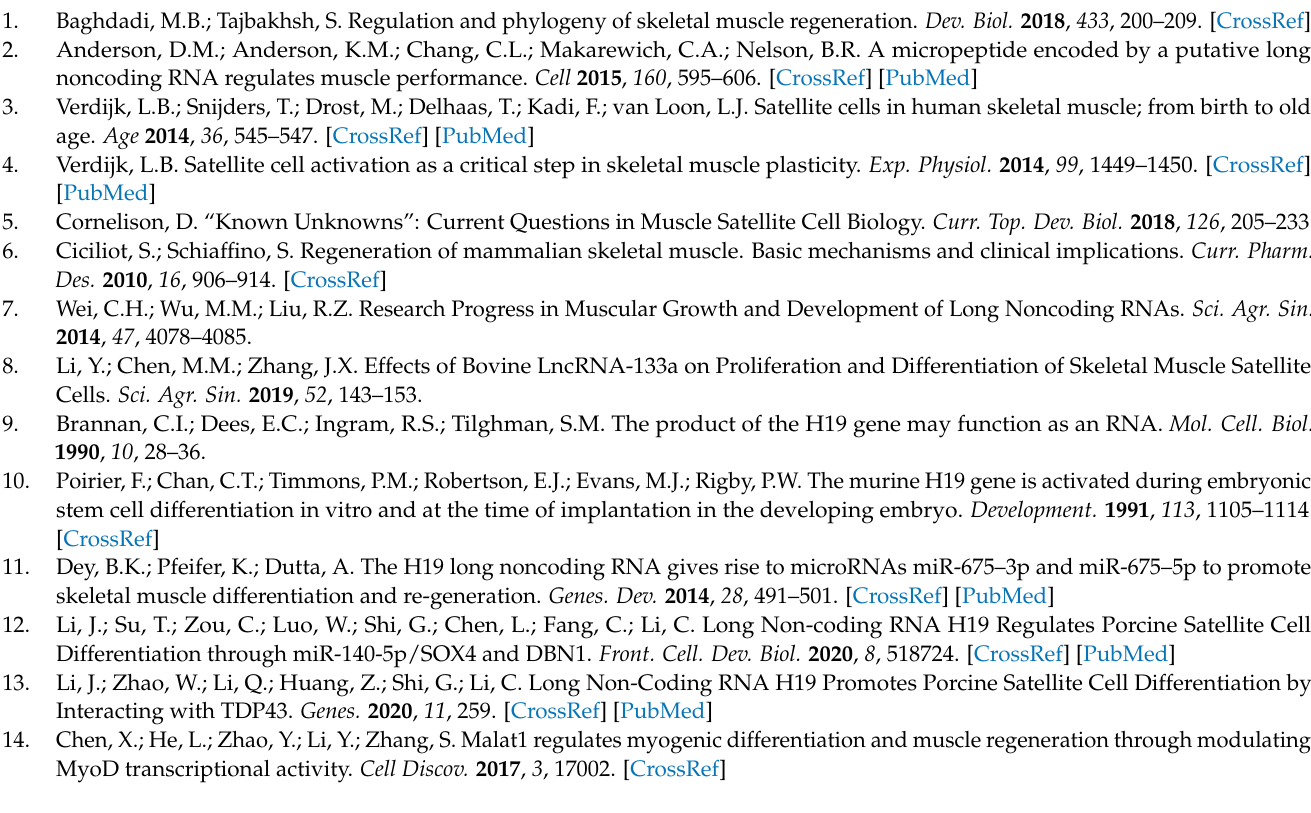
PKNOX2-enriched genes in CUT and Tag data. Table S4: The genes list of combined CUT and Tag and RNA-seq analysis. Table S5: Primer information. Table S6: RNA-seq reads information. Figure S1: TCONS_00323213 is a muscle-specific expression closely related to muscle differentiation lncRNA. Figure S2: Real-time quantitative PCR analysis of marker gene expression level in differentiated PSC 36 h after ASO- TCONS_00323213 was